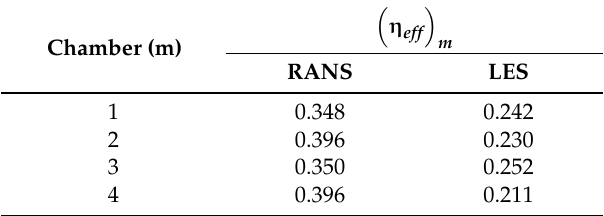
Table 2. Volumetric efficiency coefficients of each chamber for RANS and